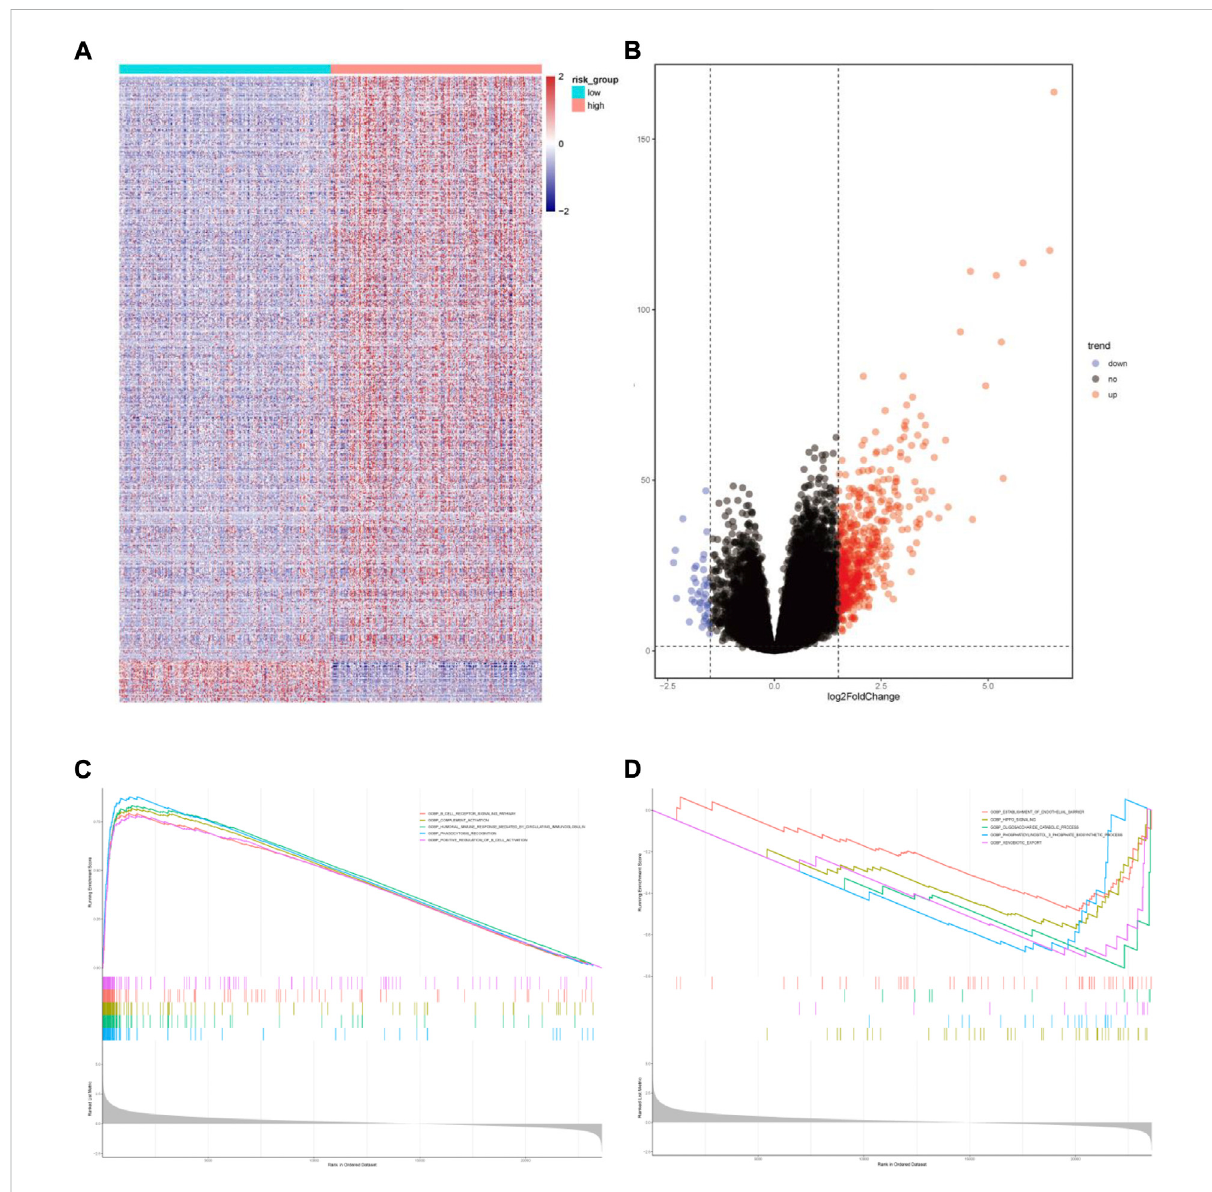
FIGURE 8 Functional enrichment analysis of differentially expressed genes between thetwo riskgroups. (A) Heatmapofdifferentially expressed genes. (B) Volcano map of differentially expressed genes. (C) Gene sets enriched in high-risk group. (D) Gene sets enriched in low-risk